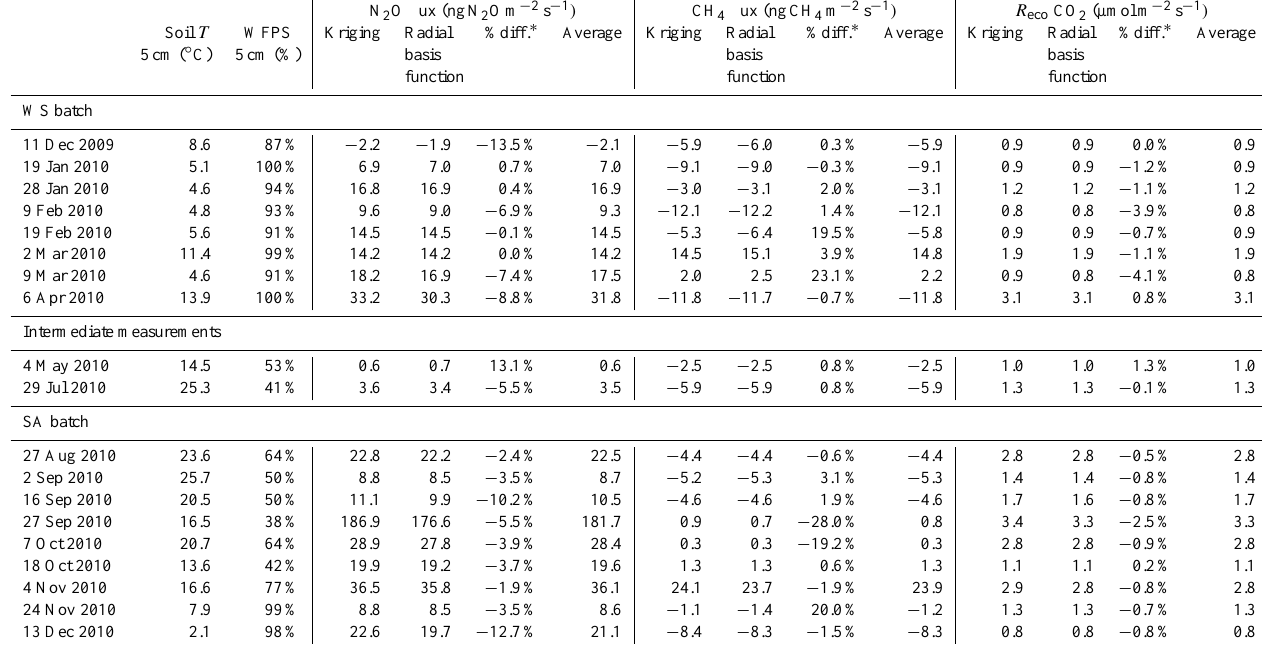
Table 3. Summary of spatially integrated GHG fluxes for each measurement day, computed using (an average of) kriging and radial basis functions to interpolate between all available individual chamber measurements. Soil temperature and water-filled pore space (WFPS) are values observed at the same time as GHG fluxes, i.e. generally around